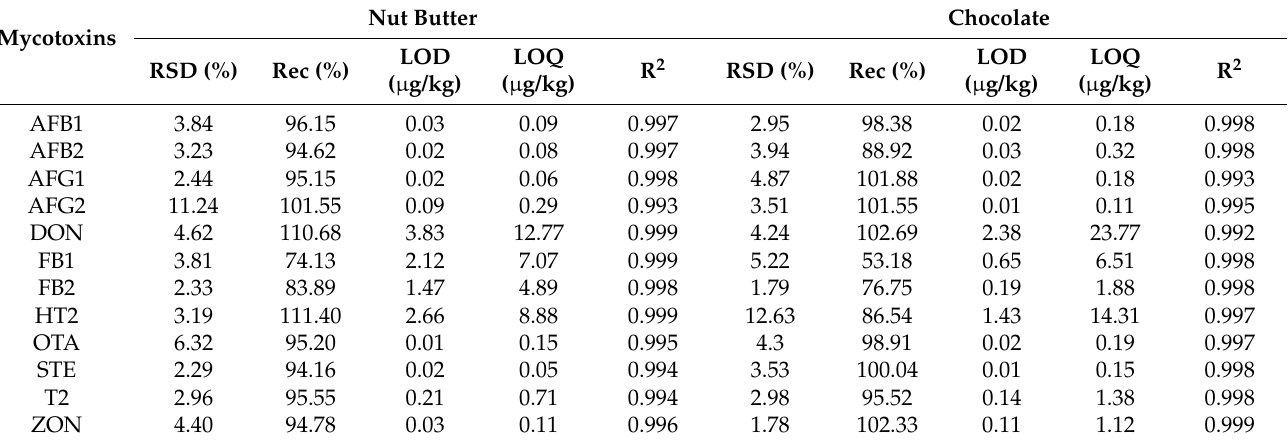
Table 6. Validation parameters of the LC–MS/MS method applied for nut butter and chocolate.